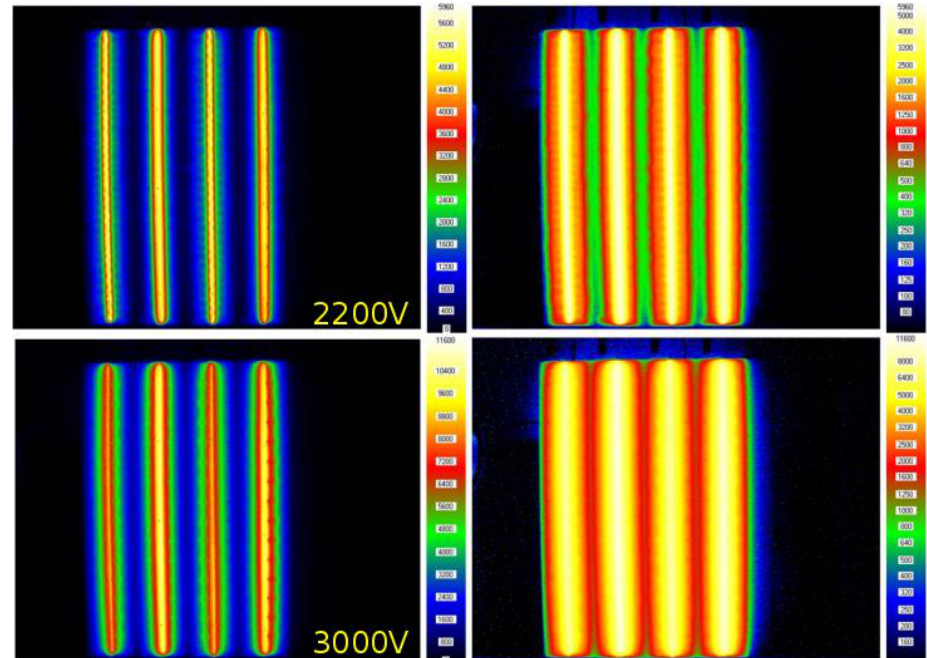
Figure 12. Mapping of the luminance for complementary electrodes configuration on 36 × 46 cm Planilum, 250 mbar, pulse 2200 V up, 3000 V down, 20 kHz, on the right, log scale; on the left, linear scale. 10 replicates, standard deviation 10%.